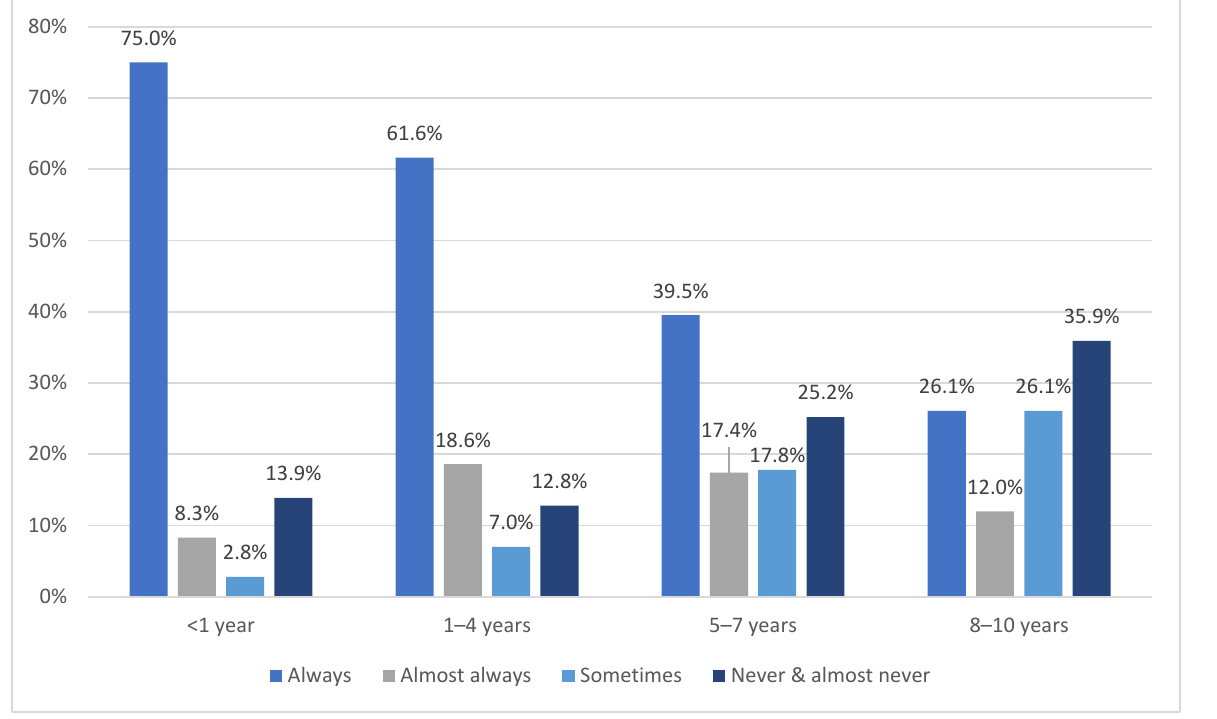
Figure 2. Child ’ s age group and frequency of restraint use while travelling in a motor vehicle. Figure 2. Child’s age group and frequency of restraint use while travelling in a motor